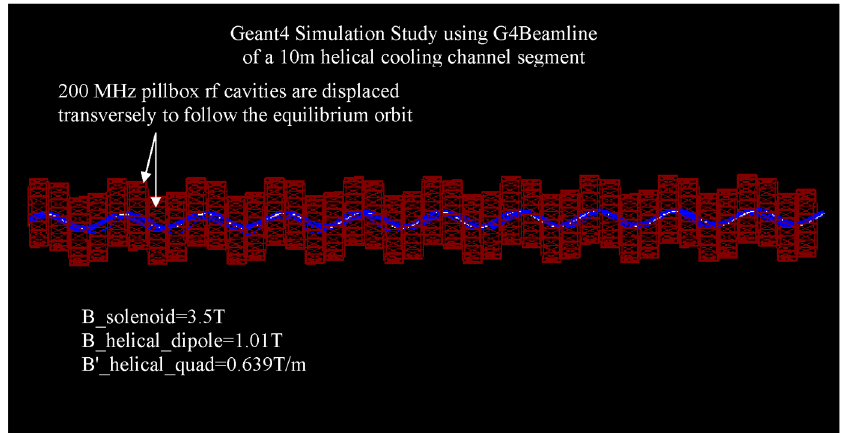
FIG. 2. (Color) G4BEAMLINE display of a 10-m-long segment of a helical cooling channel that is being simulated. The outlines of the forty 200 MHz pillbox rf cavities are shown in red. In this simulation, superimposed magnetic fields with solenoidal and helical components provide focusing and dispersion as the muons pass through the hydrogen-filled rf cavities. Muon trajectories are shown (blue) as they oscillate about the equilibrium orbit